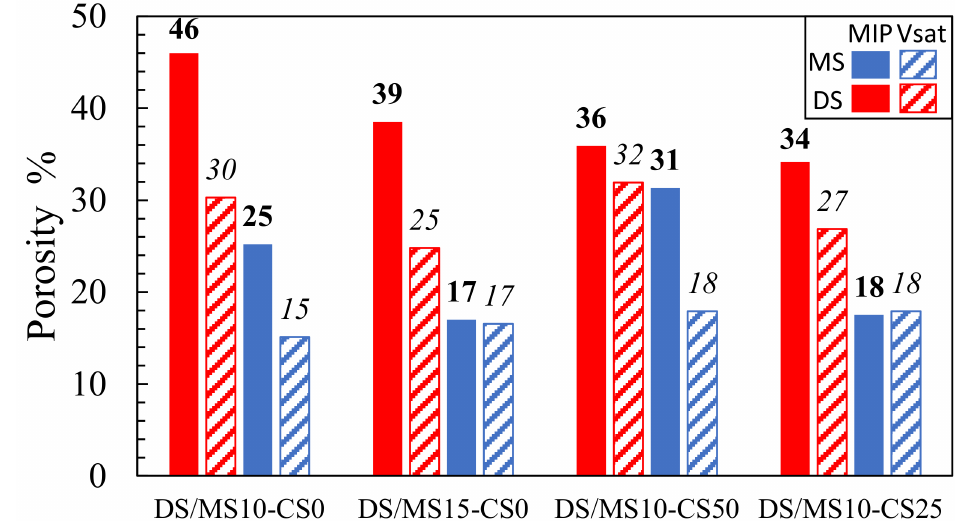
Figure 8. Porosity based on mercury intrusion porosimetry (MIP; values in bold) and vacuum saturation test (Vsat; values in italic) for samples (2) DS10-CS0 and MS10-CS0, (3) DS15-CS0 and MS15-CS0, (8) DS10-CS50 and MS10-CS50 and (9) DS10-CS25 and MS10-CS25 (see Table 2 for mix